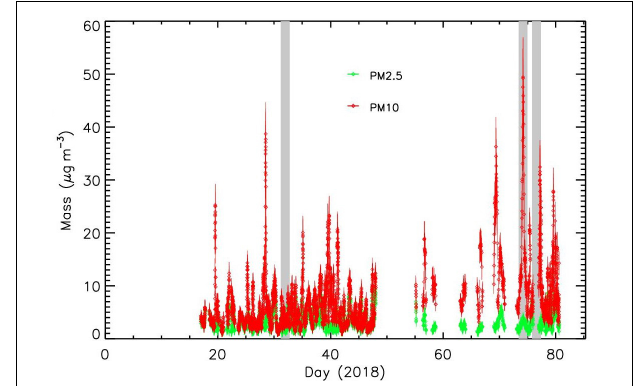
FIGURE 3 | Evolution of the PM 2 . 5 and PM 10 masses; the three events are indicated by gray